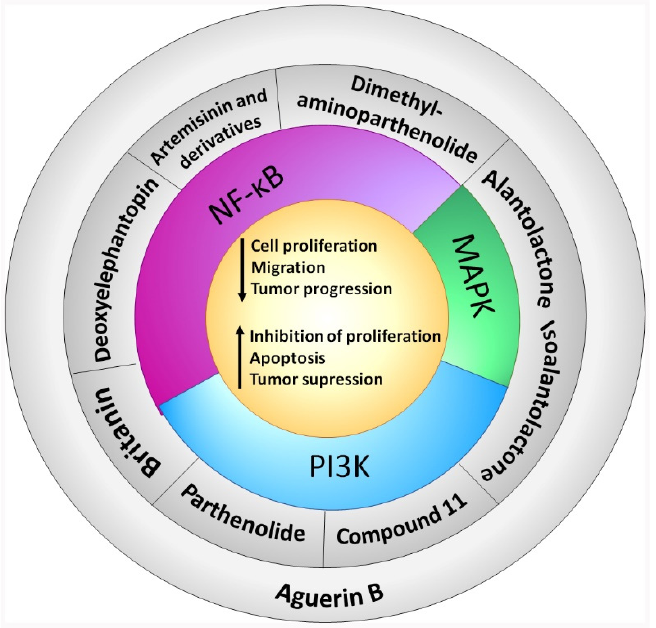
Figure 2. Sesquiterpene lactones and survival pathways. The activity of the main survival pathways upregulated by KRAS mutation are modulated by several sesquiterpene lactones. Deoxyelephan- topin, artemisinin and derivatives, and dimethylaminoparthenolide modulate NF- κ B. Parthenolide and compound 11 modulate PI3K. Britanin modulates both NF- κ B and PI3K. Alantolactone and isoalantolactone modulate MAPK and PI3K. Aguerin B modulates NF- κ B, PI3K and MAPK pathways. “Artemisinin and derivatives” refer to artemisinin, dihydroartemisinin and artesunate. “Compound 11 ” is “2 α -chloro-3 β ,9 β -dihydroxy-1 β ,10 β -epoxy-4 α ,6 α H-guai-11(13)-en-12,5-olide”.